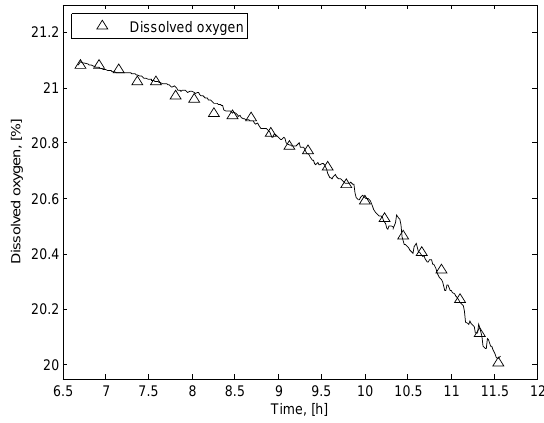
Fig. 4. Dissolved oxygen - modelled and real experimental